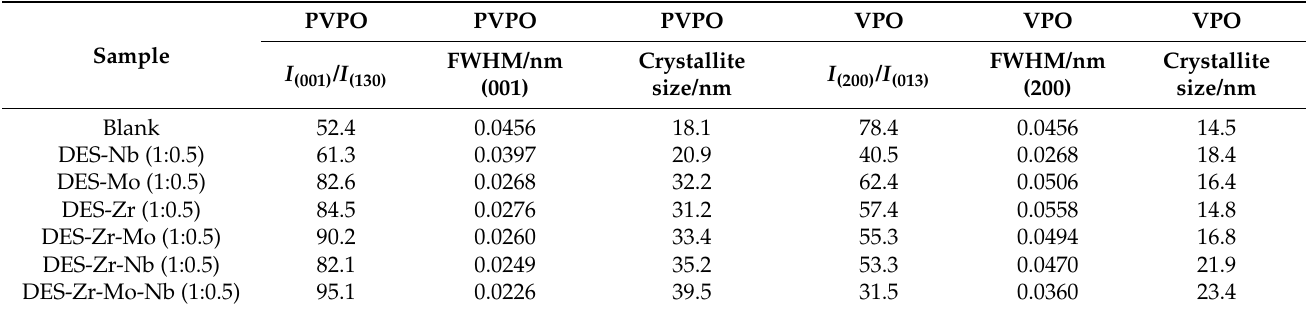
Figure 5. XRD spectra of mono- ( a ), and bi- and tri-metallic catalysts (VPO) ( b ) used to observe the main active phase (VO) 2 P 2 O 7 of the catalysts. Table 1. The crystallite size and relative integral intensity of precursors ( I (001) / I (130) ) and catalysts ( I (200) / I (013) ) are de- scribed